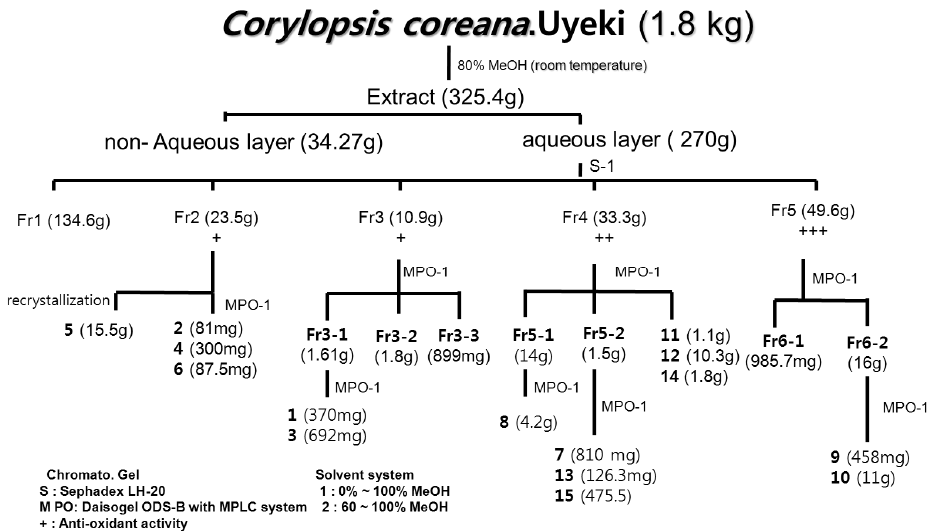
Table 1. DPPH radical scavenging and superoxide scavenging activities of each fraction from CL.